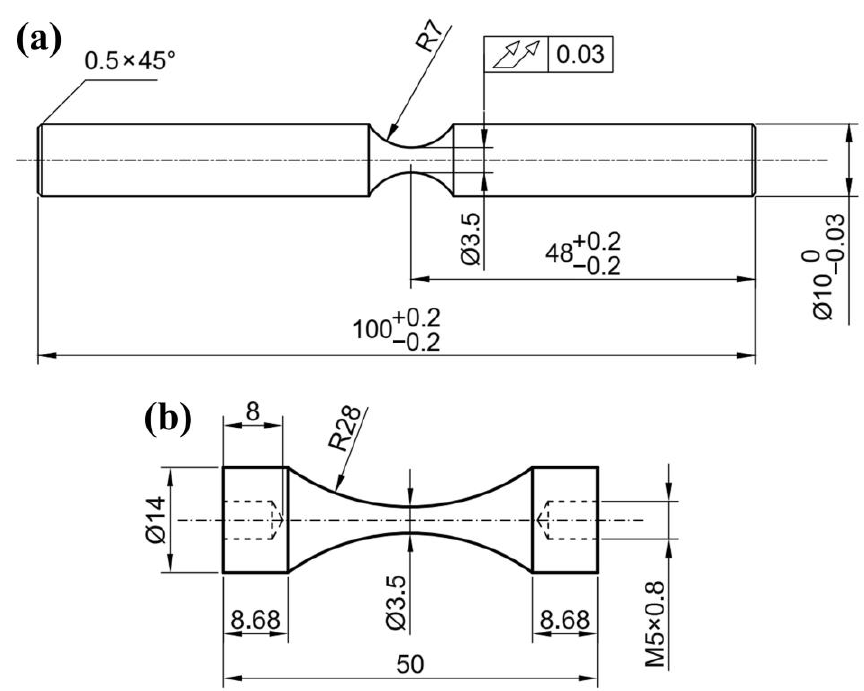
Figure 2. Specimen shapes and dimensions (mm) used in fatigue tests: ( a ) rotating bending; ( b ) ultrasonic axial loading.